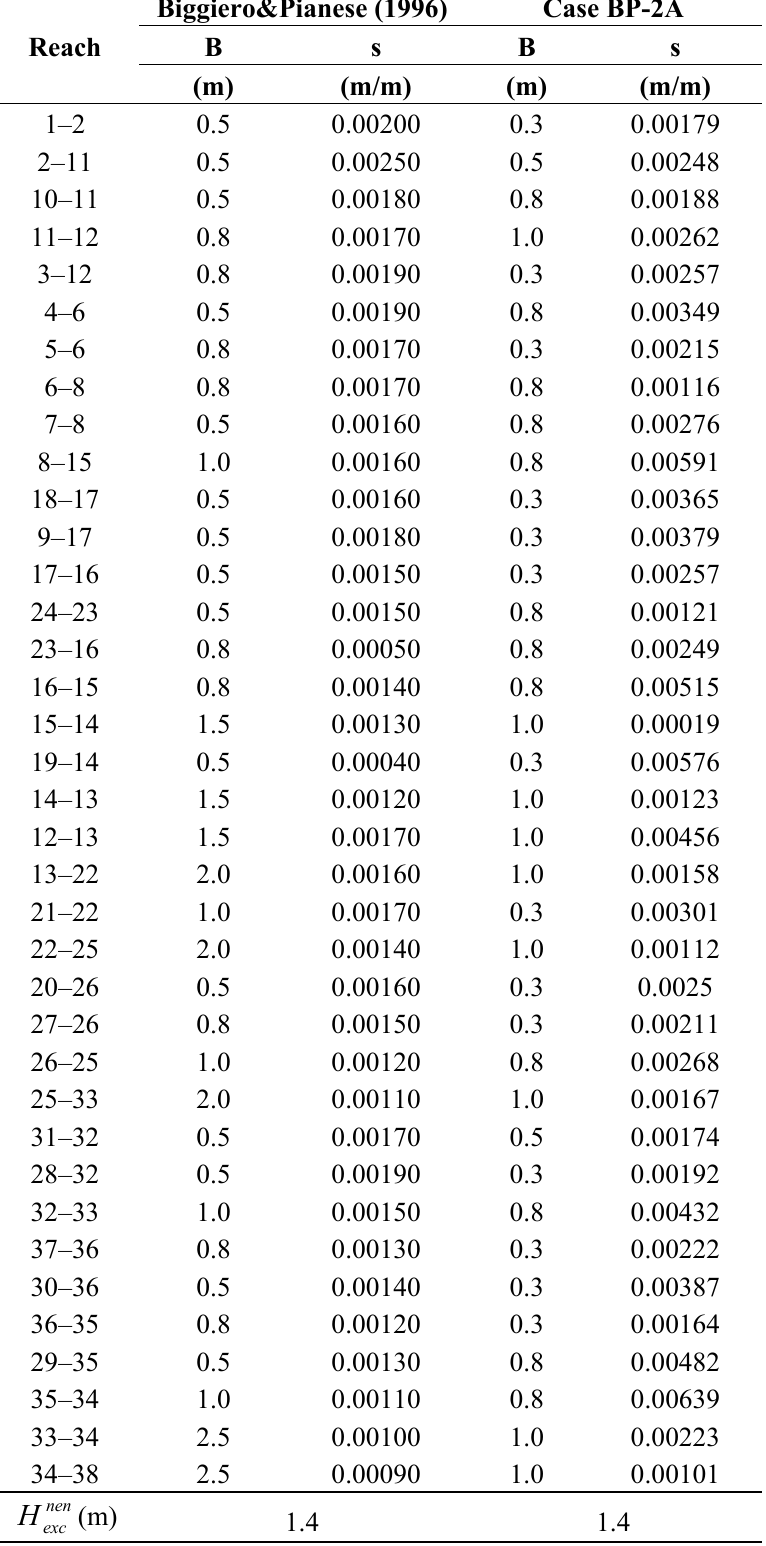
Table 10. Geometric characteristics reported in Biggiero and Pianese (1996) [64] vs. geometric characteristics obtained for the case